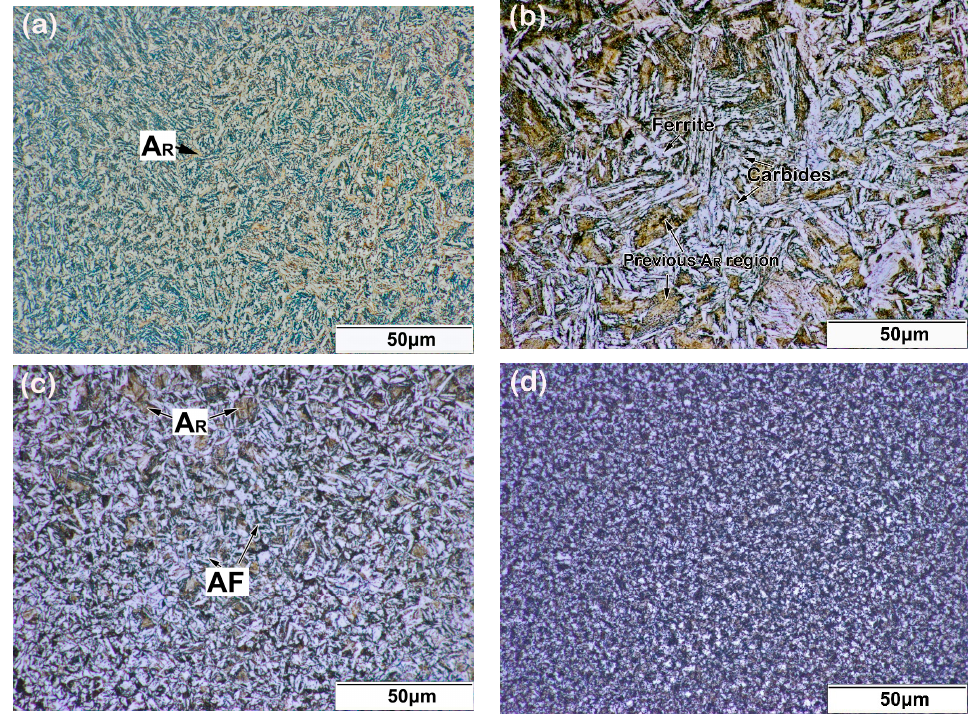
Figure 4. Microstructure of different areas in a five-layer LFR sample: ( a ) top of the laser repaired layers; ( b ) the remelt zone; ( c ) top of the heat-affected zone (HAZ), and ( d ) bottom of the HAZ.